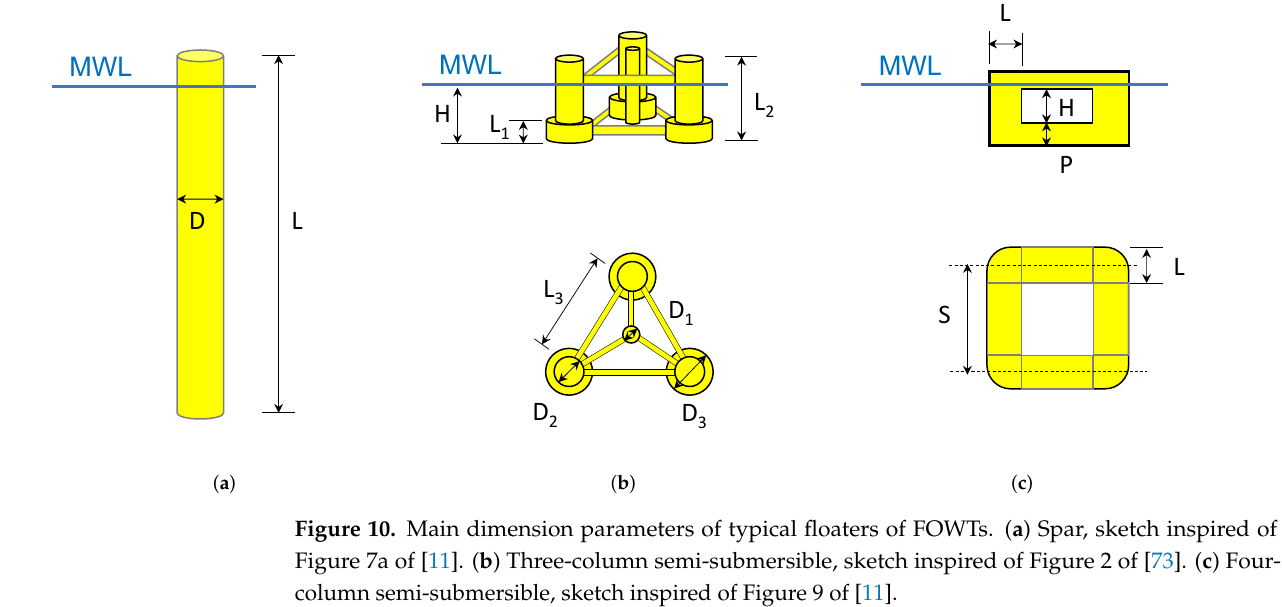
Figure 10. Main dimension parameters of typical floaters of FOWTs. ( a ) Spar, sketch inspired of Figure 7a of [11]. ( b ) Three-column semi-submersible, sketch inspired of Figure 2 of [73]. ( c ) Four- column semi-submersible, sketch inspired of Figure 9 of